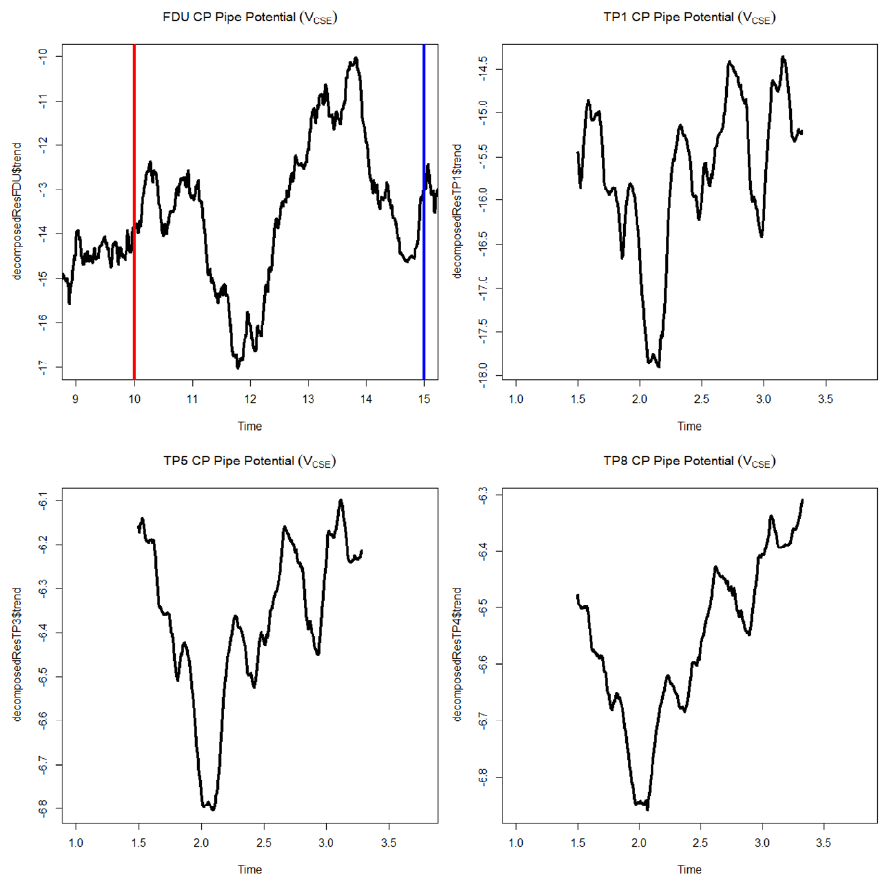
Figure 12. Downstream effect of stray current using time-series trend component.